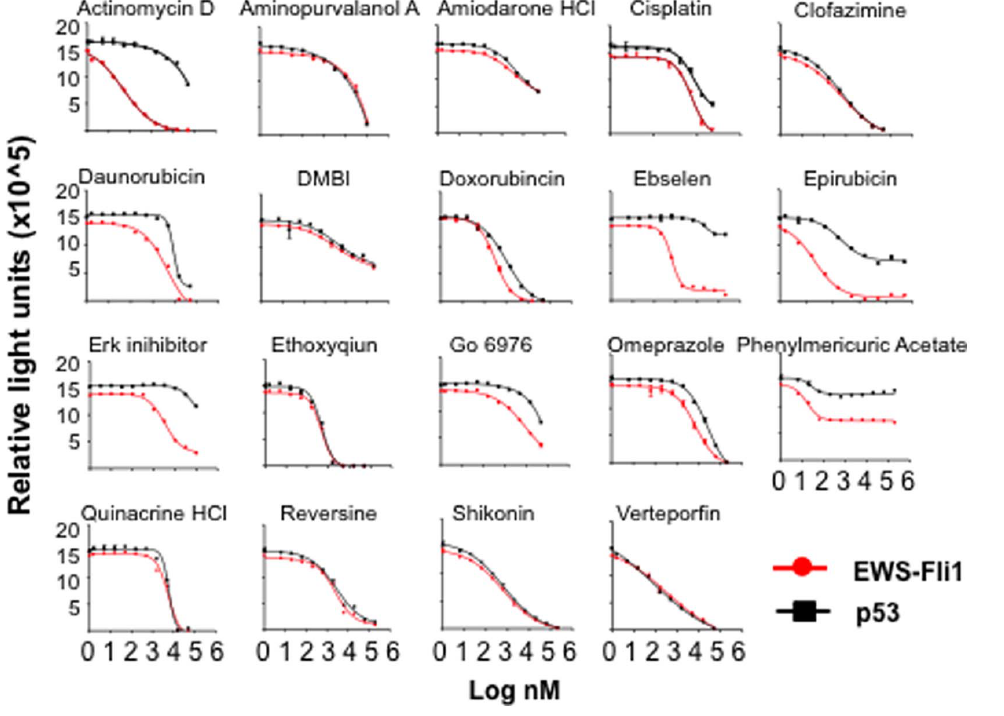
Figure 1. Biochemical disruption of EWS-FLI1 and p53 binding to DNA. Dose response for disruption of recombinant EWS-FLI1 (red lines) and p53 (black lines) binding to DNA in the presence of indicated compounds was measured using AlphaScreen proximity assays. Data plotted as mean + / 2 SD of triplicate samples and are representative of 2 independent experiments.